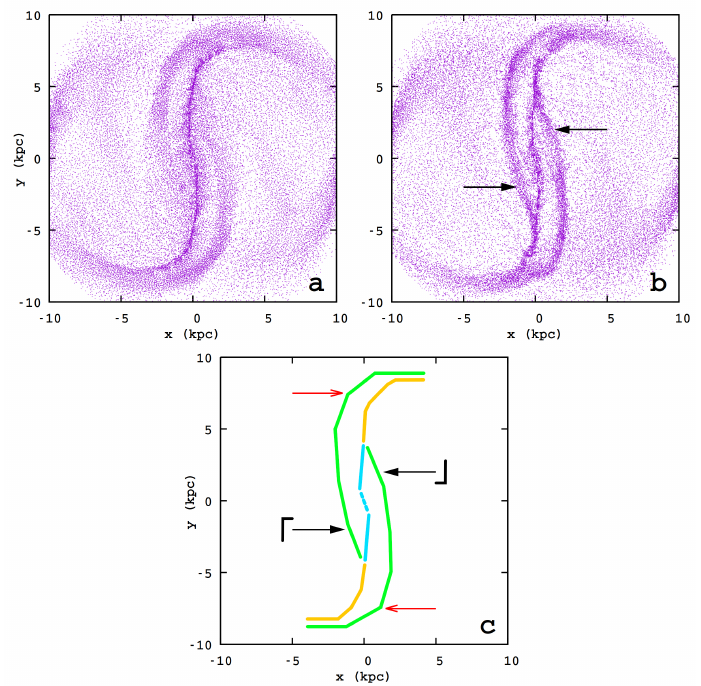
Figure 8. Characteristic snapshots of a typical model with redistribution of particles in action, at t = 0.53 ( a ) and t = 9.83 ( b ). In ( c ) we give a sketch that outlines the dense parts of the model. In the text, the green features, indicated with arrows, are described as “ Γ / L tails”. We draw the straight-line dust lane shocks and its continuations with cyan and yellow color